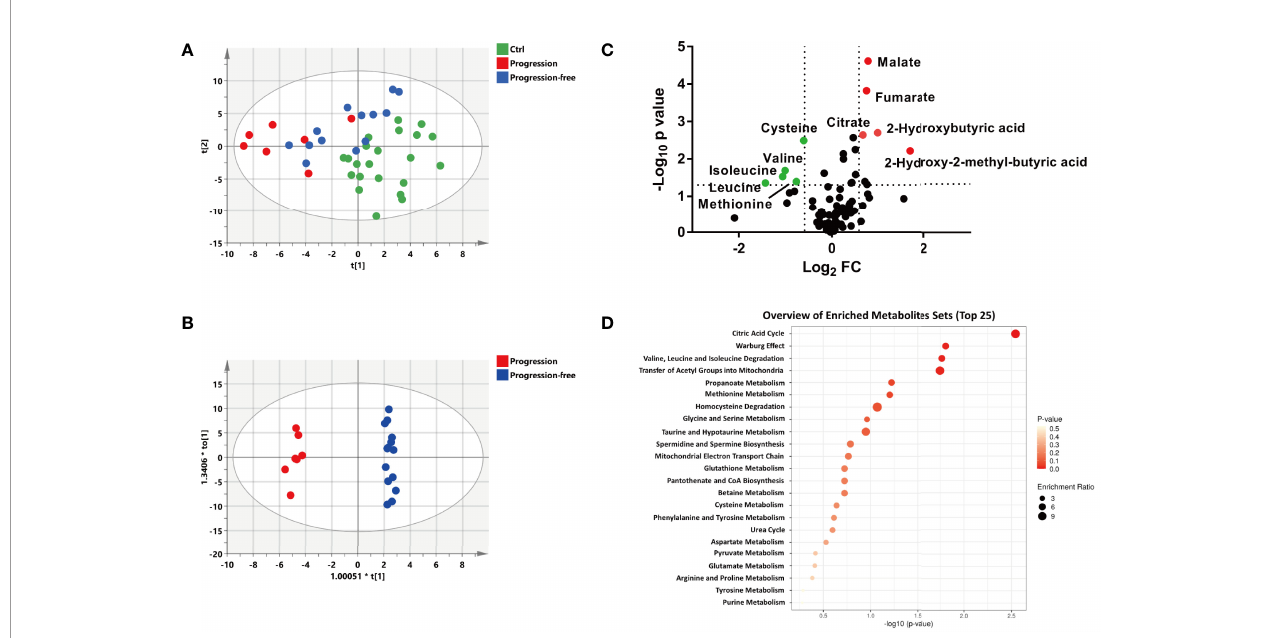
FIGURE 3 | Metabolic patterns and perturbed metabolites associated with the different outcomes of newly diagnosed DLBCL patients. (A) The PLS-DA score plot of the Ctrl, progression and progression-free groups, the parameters of the model were: R2X= 0.347, R2Y= 0.468, and Q2 = 0.254. (B) The OPLS-DA score plot of the progression and progression-free groups, the parameters of the model were: R2X= 0.594, R2Y= 0.992, and Q2 = 0.558. (C) Volcano maps of the metabolites identi fi ed from the progression-free group and progression group. Red dots represent metabolites with higher abundance while green dots represent metabolites with lower abundance in the progression group. (D) Metabolite pathway enrichment overview of plasma metabolites that displayed statistical signi fi cance and changed to a substantial